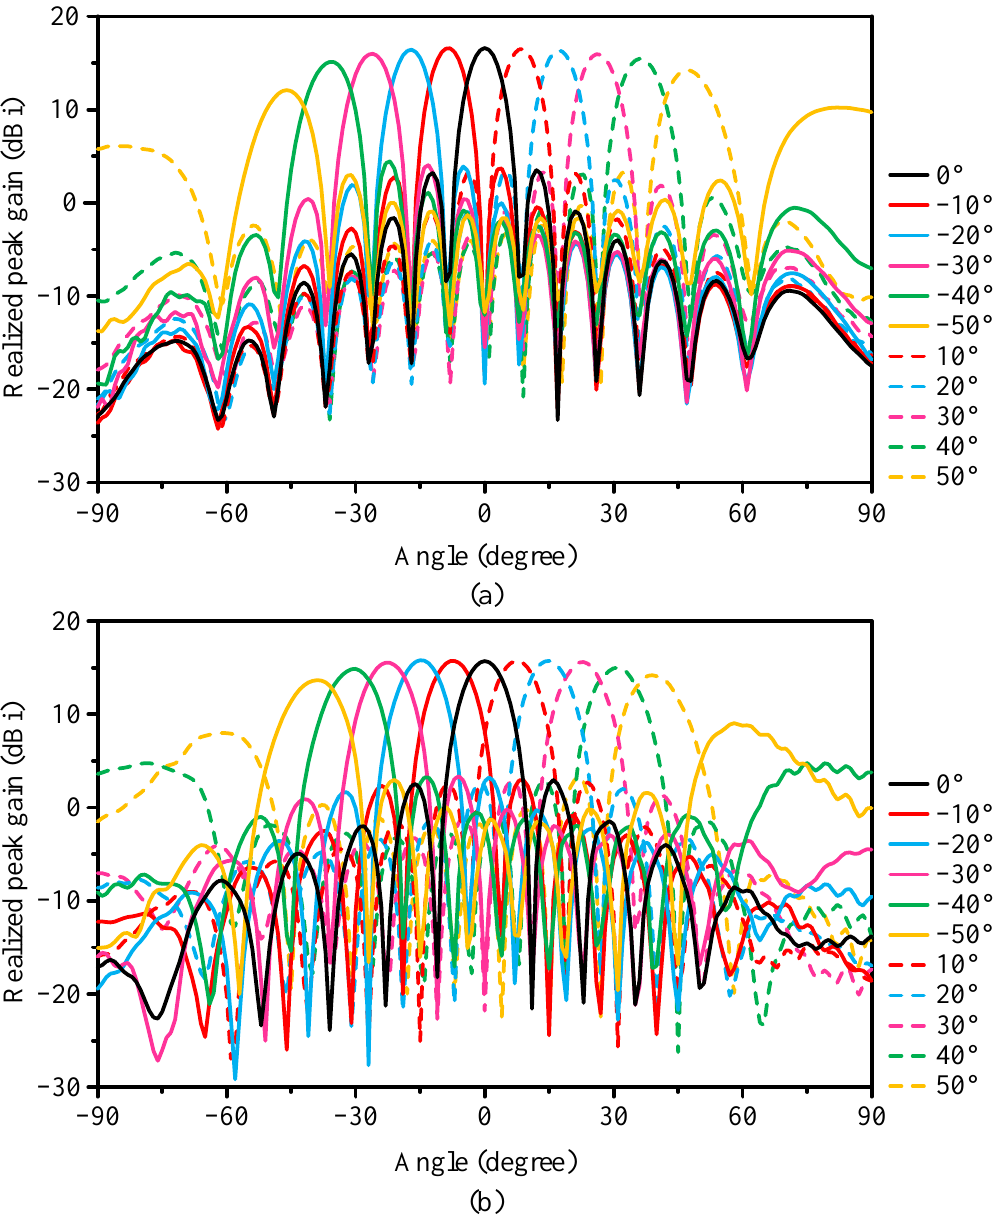
Figure 11. Beam scanning performance of ( a ) the 28.0 GHz and ( b ) 38.0 GHz antenna arrays.